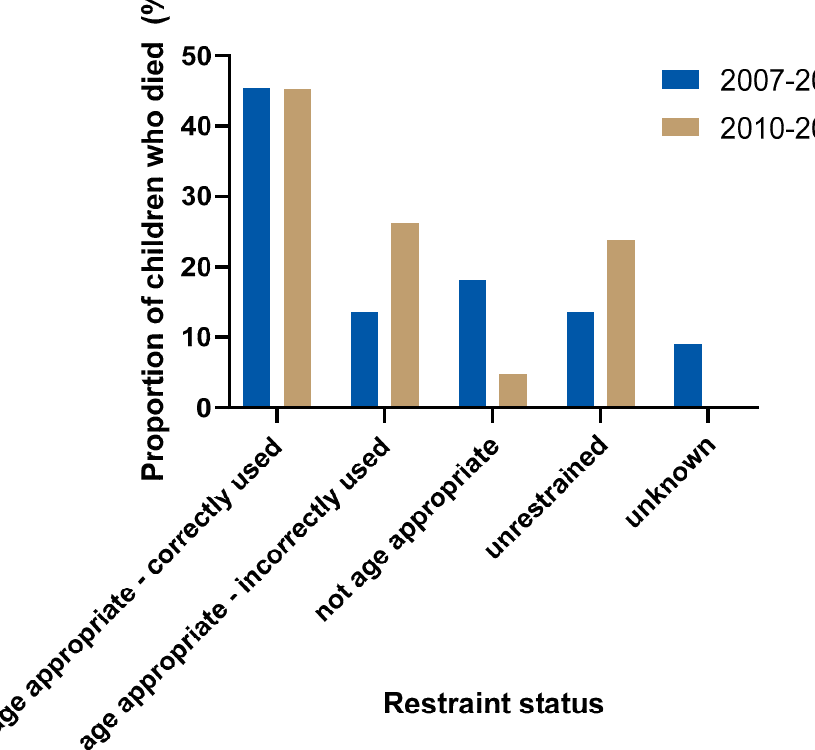
Figure 5. Restraint use status in NSW child passenger deaths pre- (2007–2009) and post- (2010–2016) child-restraint systems legislation change.